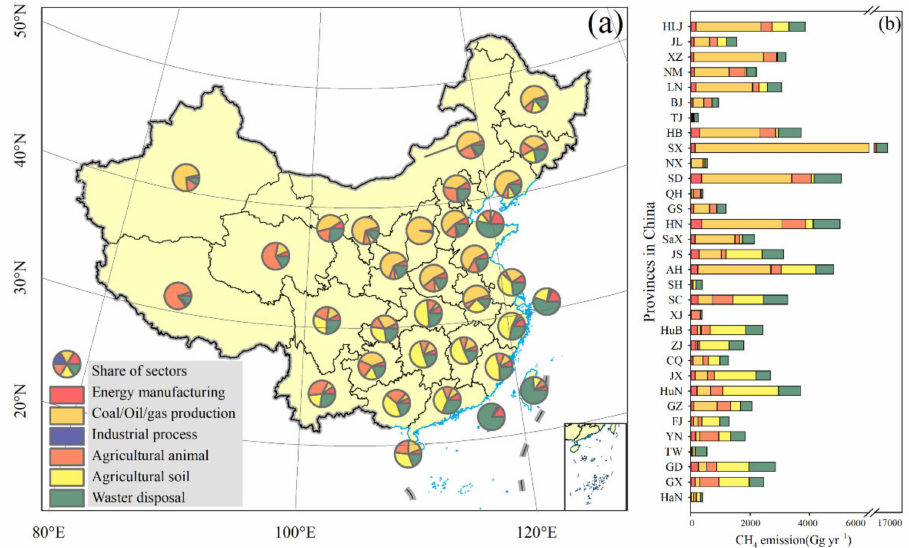
Figure A2. The share of individual sectors in the production of methane emission from EDGAR over China. ( a ) Spatial distribution of the share of individual sectors in the production of methane emission; ( b ) The share of individual sectors in the production of methane emission at provincial Scale. The abbreviations of provinces are as follows: BJ, Beijing; TJ, Tianjin; SH, Shanghai; CQ, Chongqing; HB, Heibei Province; HuB, Hubei Province; HN, Henan Province; HuN, Hunan Province; HaN, Hainan Province; SX, Shanxi Province; SaX, Shaanxi Province; GZ, Guizhou Province; XZ, Tibet